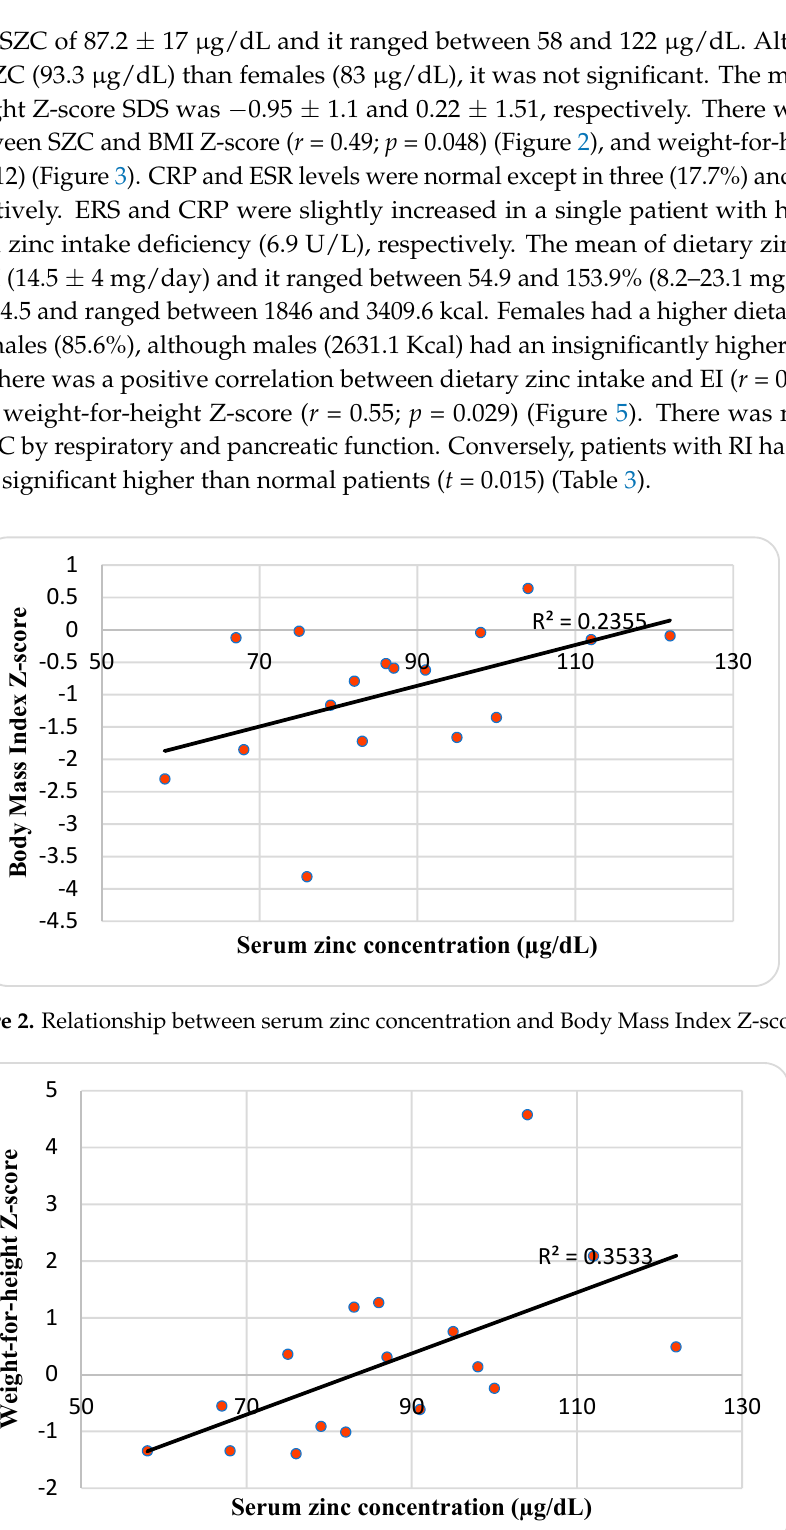
Serum zinc concentration (µg/dL) Figure 3. Relationship between serum zinc concentration and weight ‐ for ‐ height Z ‐ score.